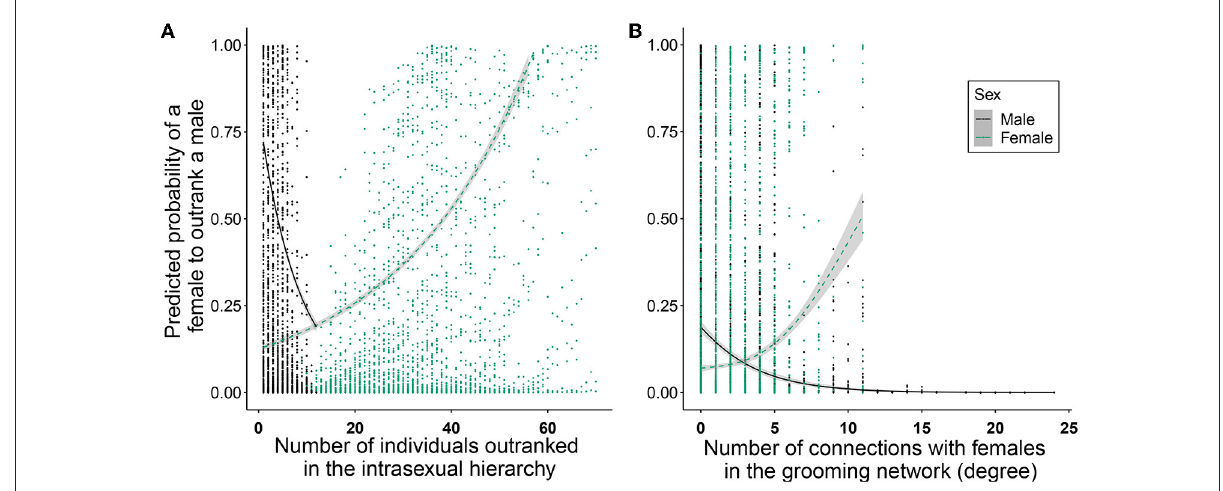
FIGURE1 Factors influencing the probability for a female to outrank a male as a function of the (A) female (green-dashed line) and male (black) intrasexual rank (number of individuals outranked) and (B) female (green-dashed line) and male (black) number of connections (degree for males and in-degree for females) in the grooming networks. The fitted values of the GLMM are shown on the y-axis and shaded areas show 95% confidence intervals.